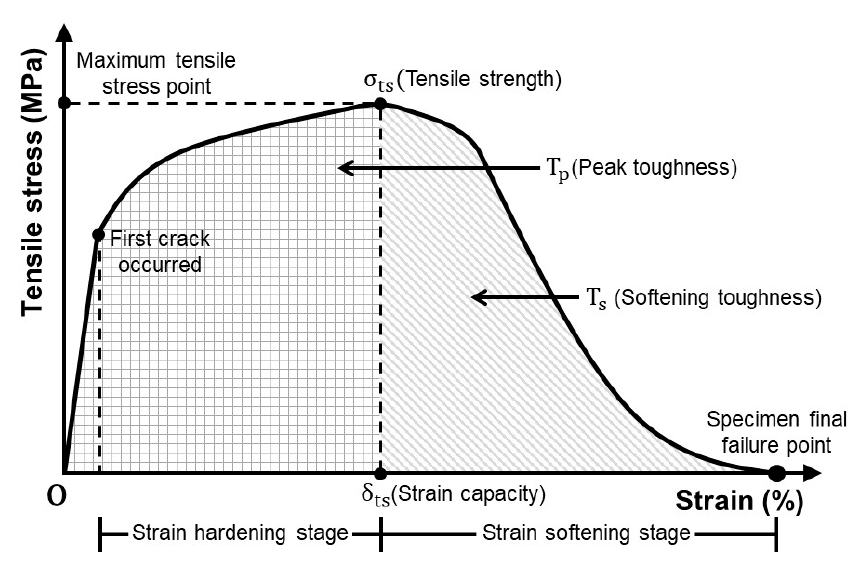
Figure 5. Tensile stress–strain curve and summary of tensile properties.